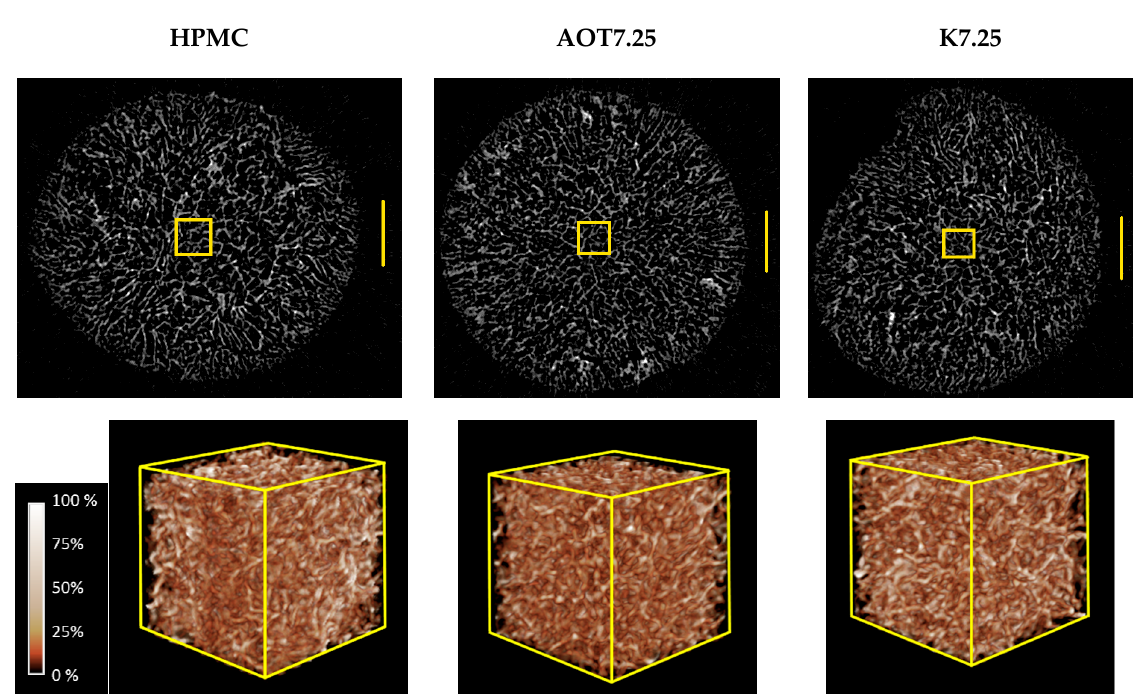
Figure 4. Reconstructed 3D models from microtomography data of HPMC, AOT7.25, and K7.25 cryogel samples. The top images correspond to transversal slices of the total diameter (ø = 5 mm), and the scale bale corresponds to 1 mm. The cubes (500 µm × 500 µm × 500 µm) correspond to the central region of the samples; the attenuation scale was obtained using the transfer function in the software CTVox ® . Black and white correspond to the minimal and maximal X-ray attenuation, respectively. Table 3. Volume of interest (VOI), internal area of the VOI (A), connectivity density (the average number of connections in 1 mm 3 , specific area ( A sp )), and mean pore size calculated with CTAn ® software.